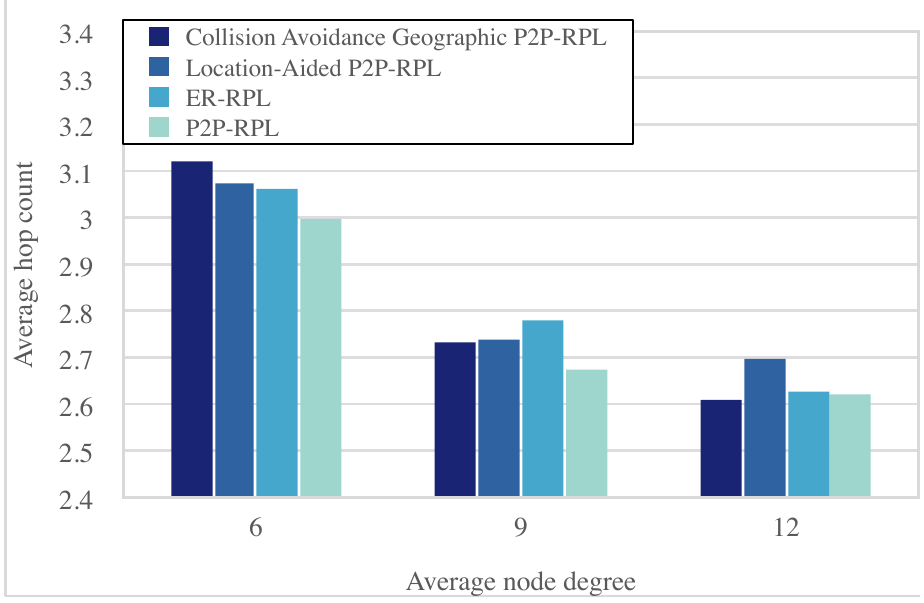
Figure 10. The average hop count versus the average node